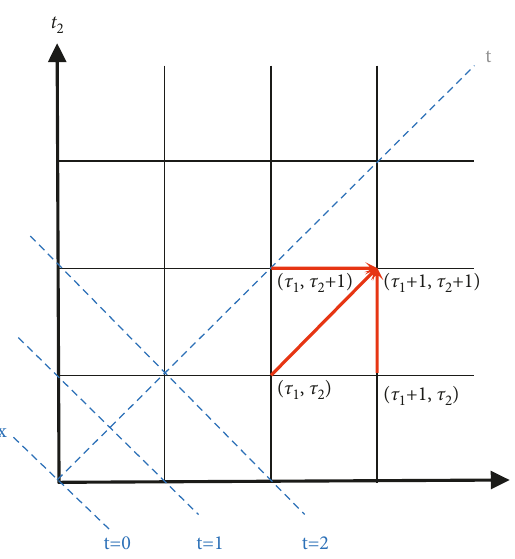
Figure 2: Coordinate system transformation and iterative format of transfer matrix of